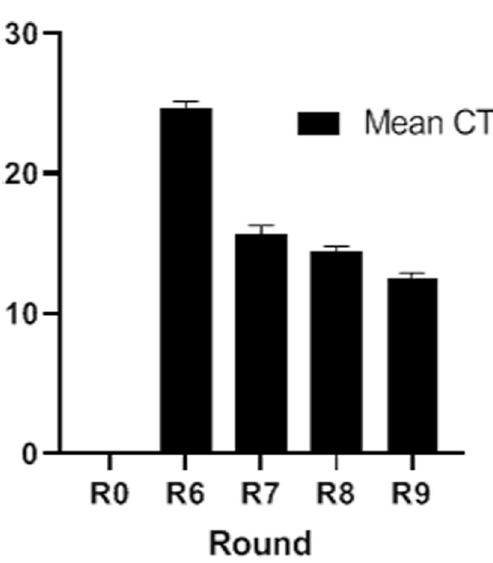
Figure 2. Real-Time PCR results. The result of the amplification of rounds zero (negative selection), R6, R7, R8 and R9 with the One Step SYBR TaKaRa kit. The mean values of Ct of each round have been demonstrated in the graph bar. Round 9 was selected as the optimum round with the lowest Ct